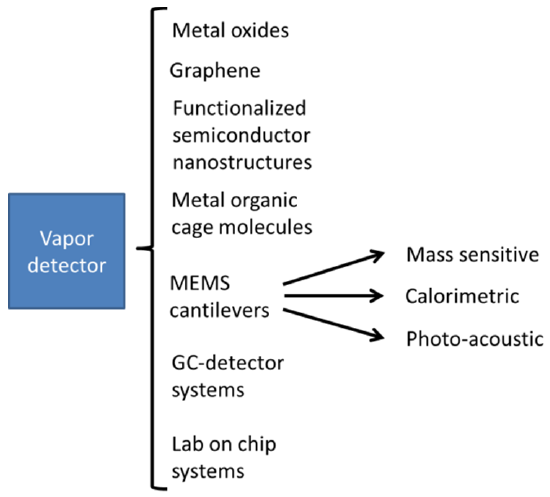
Figure 25. Families of chip ‐ sized backend vapor detectors that form viable alternatives to the backend MOX gas sensors used in this work.